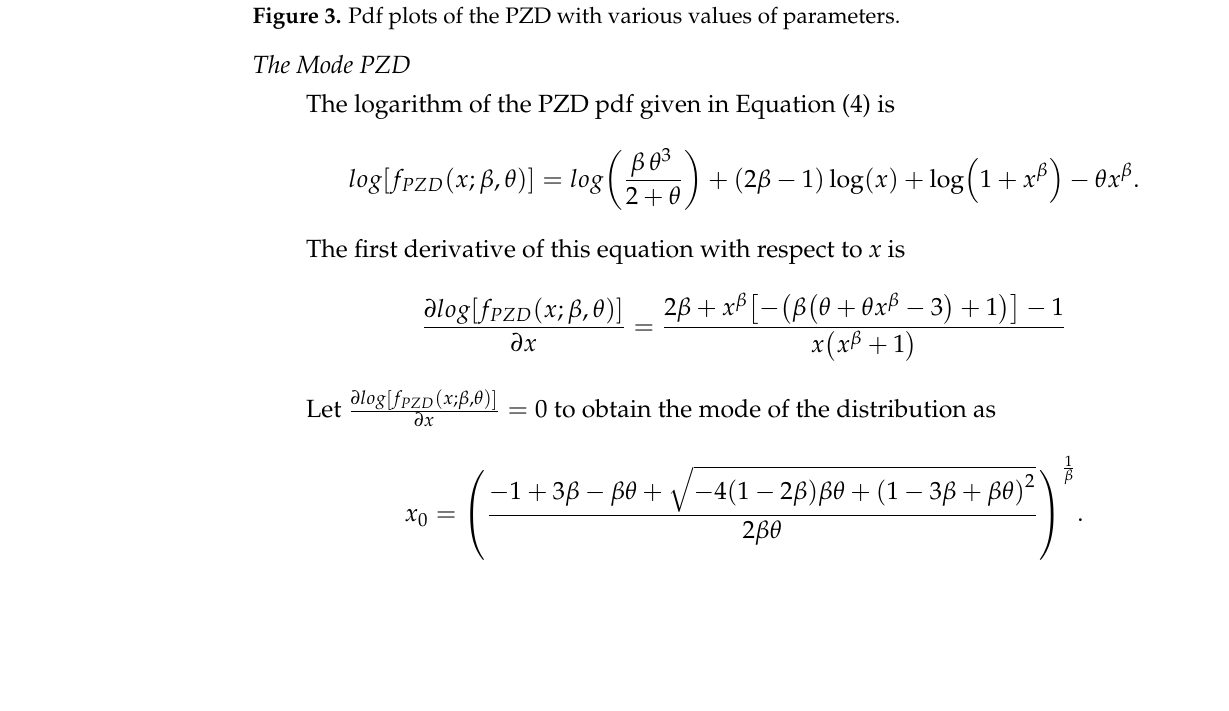
Figure 3. pdf plots of the PZD with various values of parameters. Figure 3. Pdf plots of the PZD with various values of parameters. The Mode